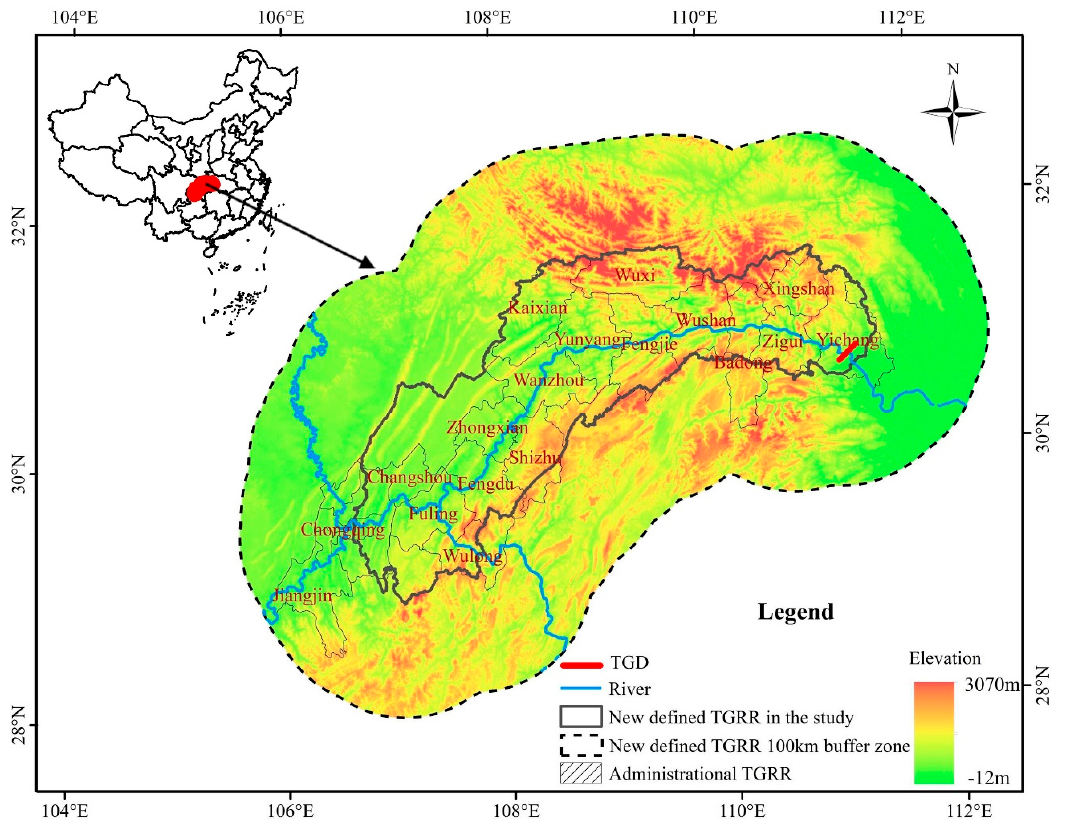
Figure 1. Geographic location and elevation of the study area.